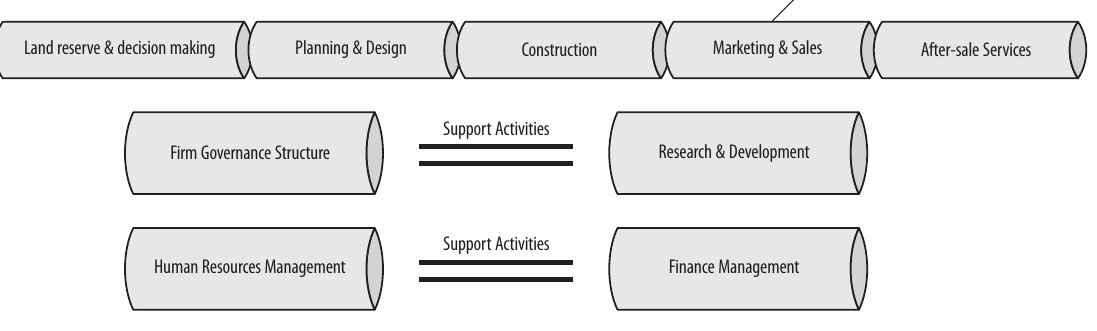
Figure 4. The value chain model (VCM) for